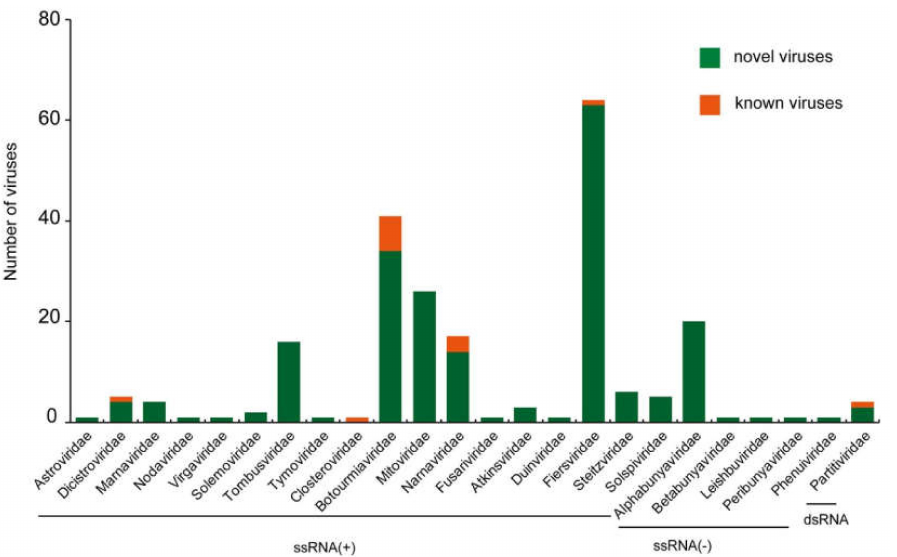
Figure 1. Overview of viral species identified in this study. According to the Baltimore classification, viruses identified in this study are classified into ssRNA(+), ssRNA(-) and dsRNA. The name of the classification is under the